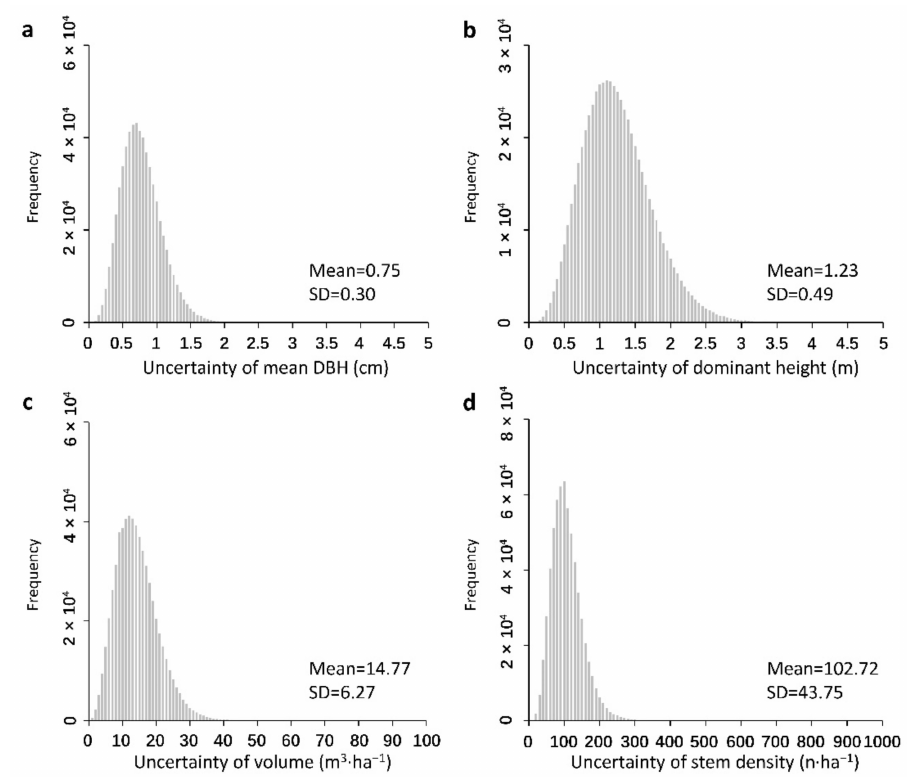
Figure 10. Histograms of uncertainties in the spatial extrapolation procedure for forest structural parameter uncertainty maps. Subfigures ( a – d ) represented the histogram of uncertainty of mean DBH, dominant height, volume and stem density,